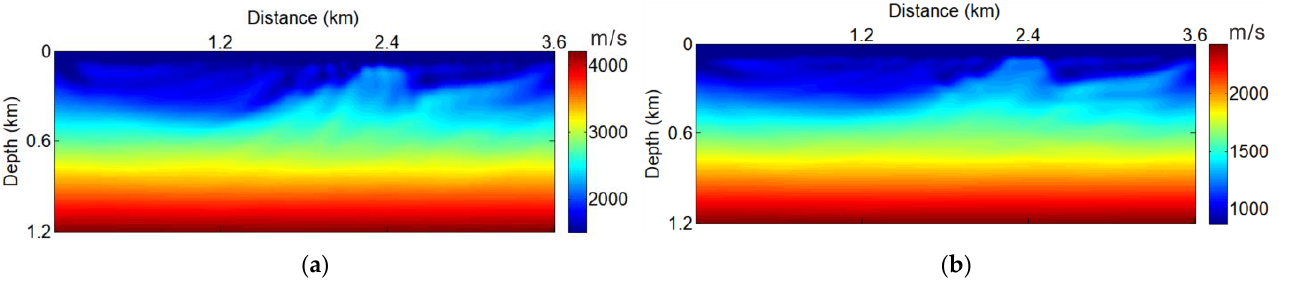
Figure 8. Low-frequency data (5–10 Hz) based PC-EFWI results with phase correction factor ε = 0.5;